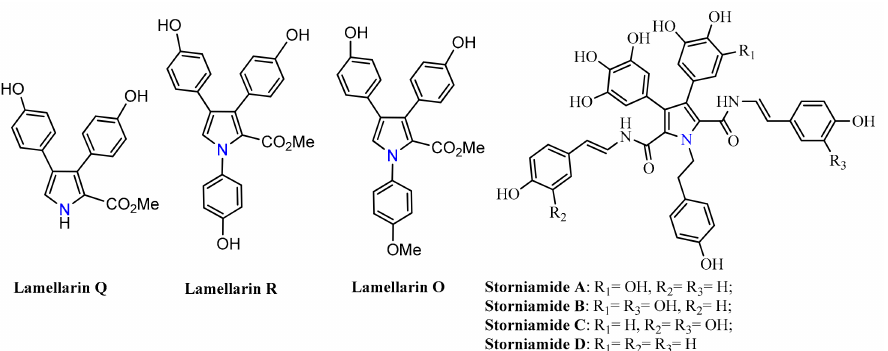
Figure 2. Structure of some marine pyrrole alkaloids.